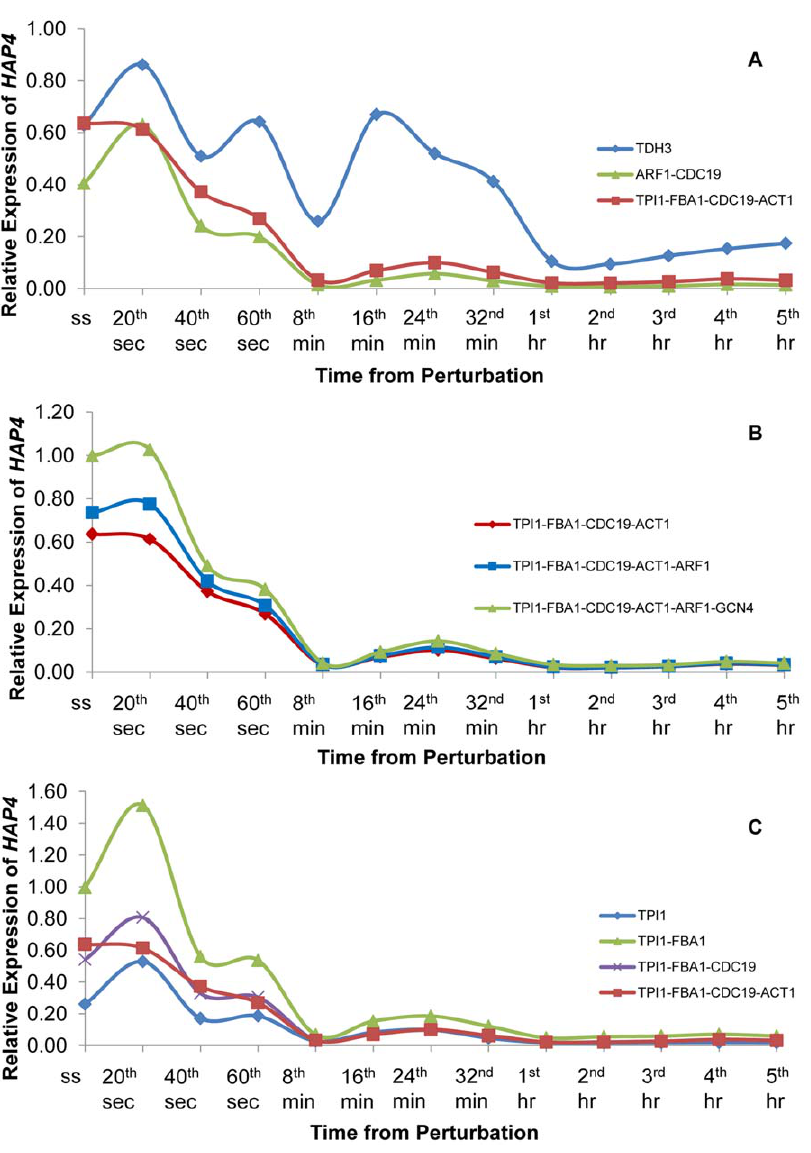
Figure 2. Expression profile of HAP4 in response to the relaxation from glucose limitation. This figure represents the expression profile for HAP4 using different combinations of reference genes, which were selected from the candidate pool. The expression profiles were calculated using TDH3 ; a commonly selected reference gene, using ARF1 and CDC19 ; the two most stable genes identified from P-0 by geNorm, and using TPI1 , FBA1 , CDC19 and ACT1 ; the final set of most stable genes (A). The contribution of increasing the number of genes in the final reference set to the expression profile of HAP4 was investigated by adding ARF1 and GCN4 to the reference gene set in the given order (B). The effect of reducing number of genes in the final reference gene set on the expression profile of HAP4 was investigated. The number of reference genes included in the set was reduced by one each time starting from the least stable gene in the set (C). For each individual profile, the reference genes, which were used in the determination of HAP4 expression, were indicated by different colours in the